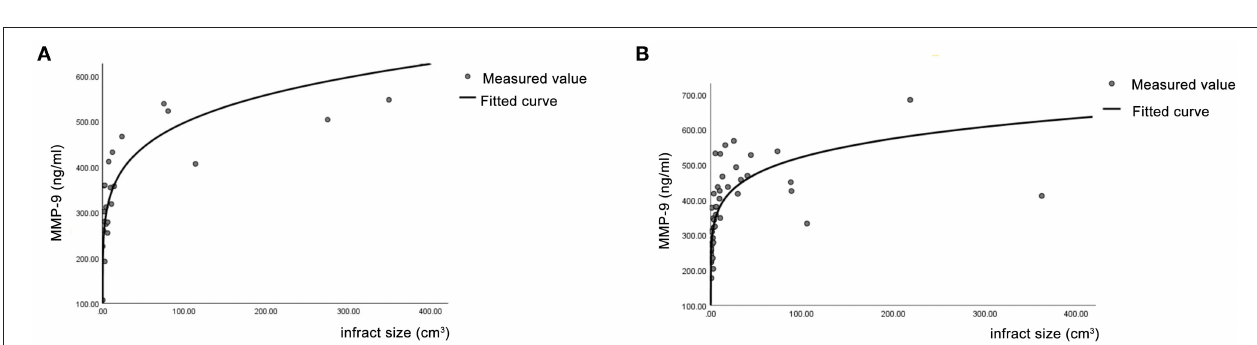
FIGURE 3 | Correlation analysis between the infarct volume and MMP-9 (day 1). (A) The conventional treatment group. (B) The butylphthalide group.